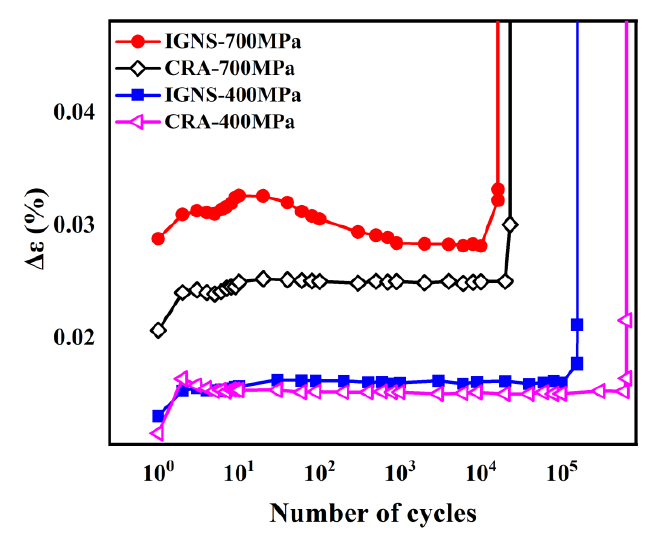
Figure 10. Cyclic deformation curves of the IGNS and CRA samples under different stress ampli- tudes.